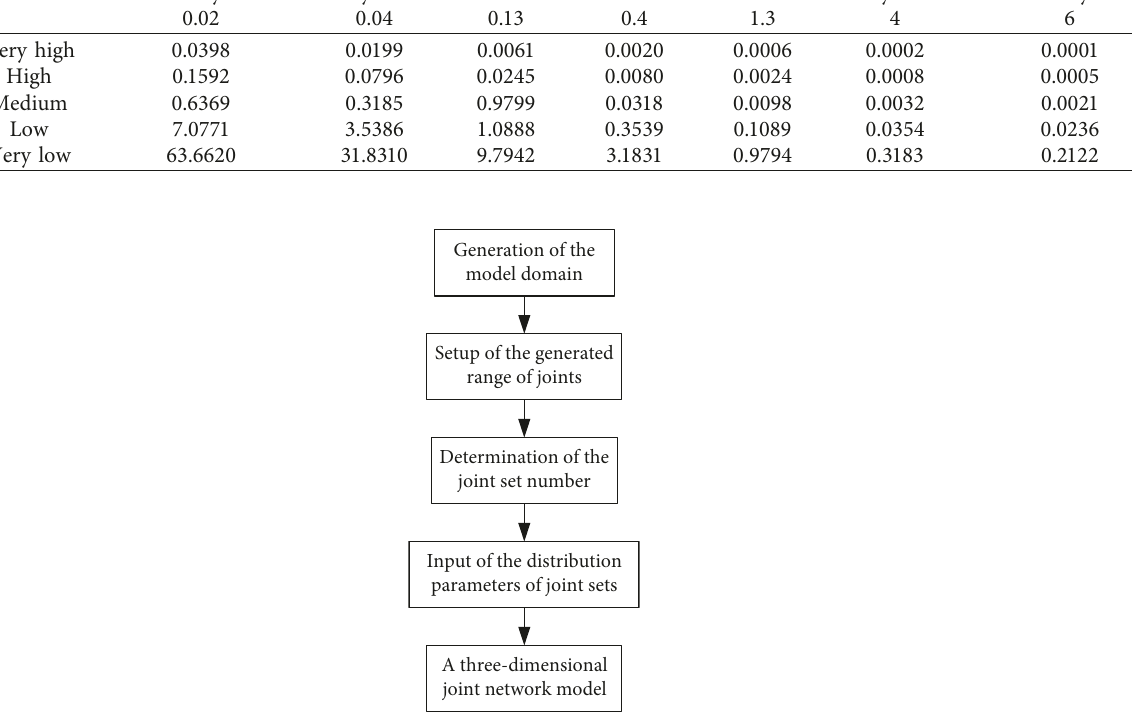
Figure 2: Flow chart of the generation of a three-dimensional joint network